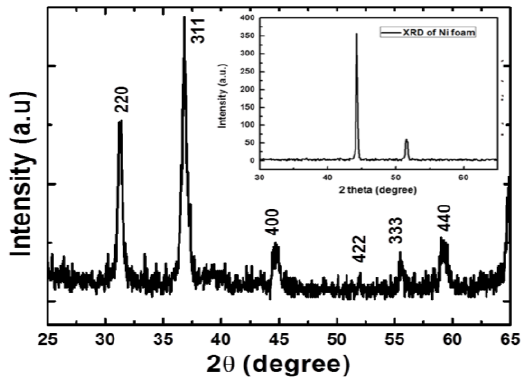
Figure 2. The XRD spectrum of NiCo spectra of bare Ni foam substrate.